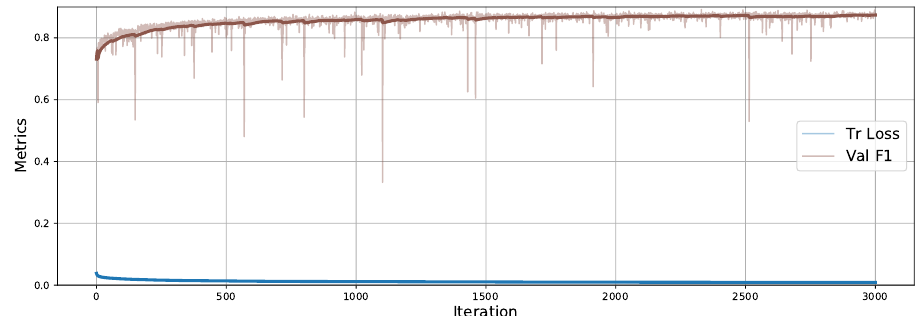
Figure 6. Training history of the model configured with C1 with two-stage training (C1-2ST-Long) on dataset D 2 . The plot depicts the evolution of the training loss and F1 score on the validation set over the 3000 epochs in the second stage. Bold lines indicate a running average with window of size 30.